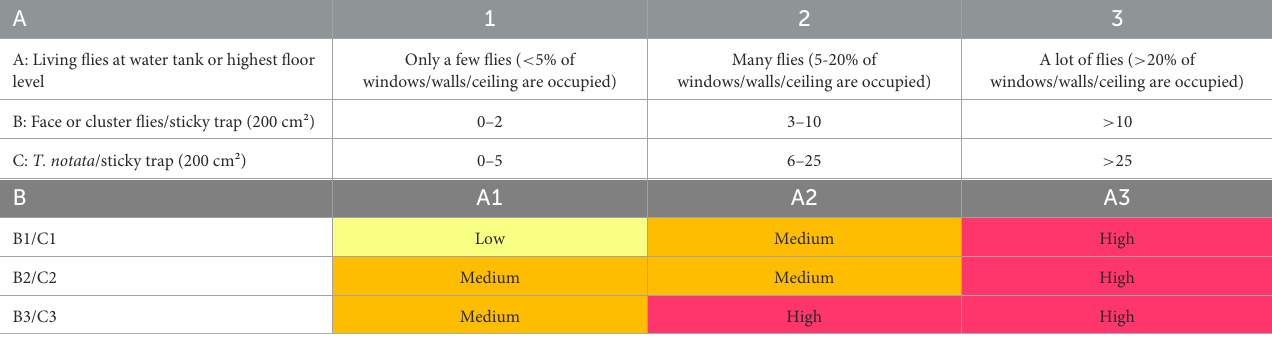
TABLE 2 (A) Classification of fly presence in water towers based on visual inspection of living flies on walls and ceiling and flies caught on sticky traps on the level of the water, (B) Risk assessment matrix that evaluates the risk of the presence of flies on microbial contamination of drinking water based on the classification system by visual inspection and expert judgement by the Flemish drinking water providers (low risk: yellow, medium risk: orange, high risk: red).